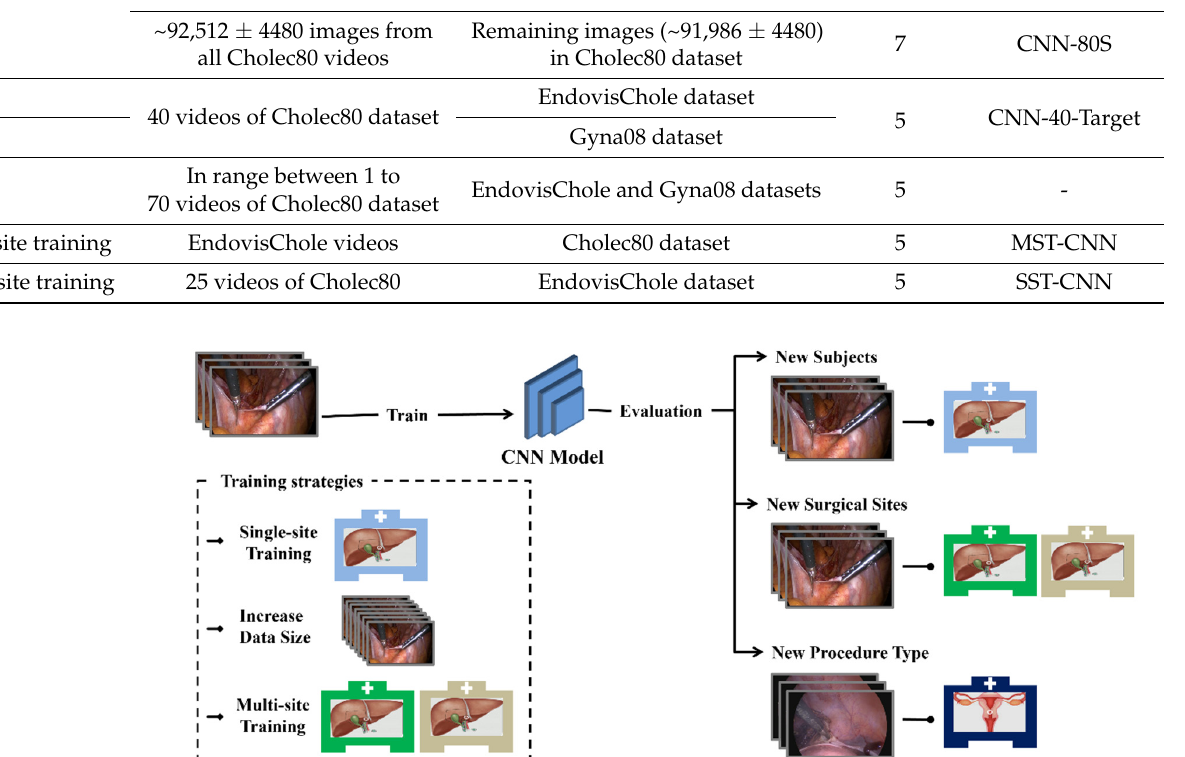
Figure 3. Diagram of the conducted experiments. Table 3. Summary of the conducted experiments.